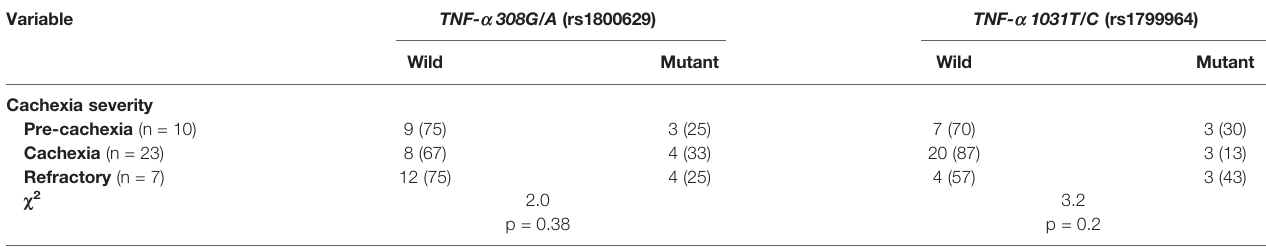
TABLE 3 | Distribution of TNF- a gene genotype among cachectic NSCL cancer patients considering the cachexia severity.